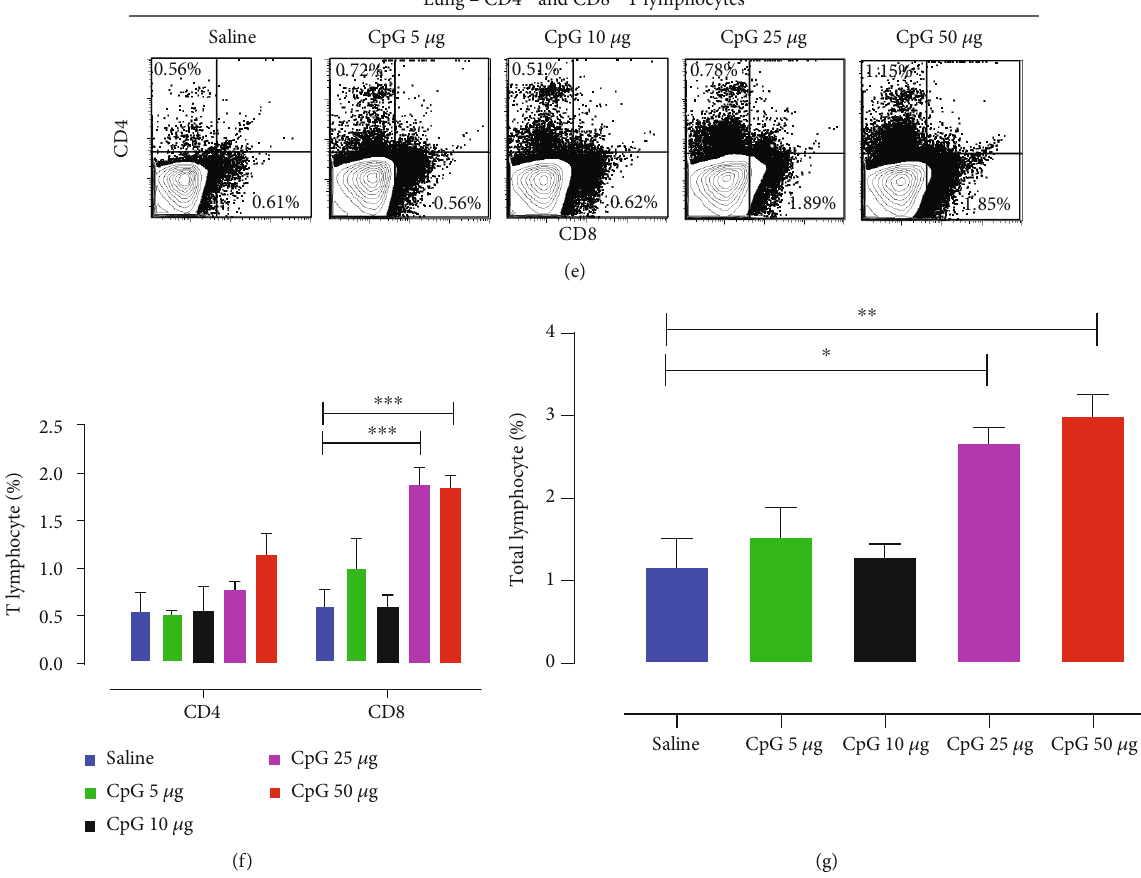
Figure 1: CpG-ODN-induced a dose-dependent enrichment of lung immunological niches. CpG-ODN treatment resulted in an increase in the number of in fi ltrating antigen-presenting cells and T lymphocytes in the lung. Flow cytometric analysis of lung cells at 72 hrs post in ovo injections (day 21 embryo) ( n = 3 ‐ 4/group ). First, cells were plotted based on forward vs. side scatter to gate monocyte/macrophage populations. Then, using PE-labeled mouse anti-chicken monocyte/macrophage (clone: KUL01) and AF488-labeled mouse MHC II monoclonal antibodies, the double-positive population was gated to quantify the number of APCs (dot plot panels, a). Bar diagrams (b) show the means of the total percentage of MHC II + APC in various groups. Histogram panels (c) indicate the level of CD40 expression on MHC II + APCs (the MFI is indicated). Black histogram=isotype control, blue=saline, and red =CpG-ODN treated. Bar diagrams (d) show the means of MFI of CD40 expression on MHC II + APC (vertical line and horizontal bar show the standard error of mean-SEM), n = 3 ‐ 4 . Dunnett ’ s test following ANOVA testing was used to test for signi fi cant di ff erences between CpG-ODN doses and the saline control group. Asterisks indicate groups that were signi fi cantly di ff erent from the control group ( P < 0 : 05 ). (MFI — geometric mean fl uorescence intensity). (e – g) Flow cytometric analysis of lung T-cell populations in each group ( n = 3 ‐ 4 ) at 72hr post in ovo injections (day 1 hatch). CD4 + and CD8 + T-cells in the lung (dot plot panels, e) were quanti fi ed using PE-labeled mouse anti-chicken CD4 and FITC-labeled mouse anti-chicken CD8 monoclonal antibodies. Bar diagrams show CD4 + and CD8 + T-cell number in the lungs (f), and the total number of CD4 + T-cells and CD8 + T-cells combined (g) in various groups. Two-way ANOVA following the Bonferroni posttest was done when CD4 + and CD8 + cells were compared between CpG-ODN received groups and saline control. Dunnett ’ s test following ANOVA testing was used to test for signi fi cant di ff erences in total T-cells between di ff erent CpG-ODN doses and the saline control group. Vertical line and horizontal bar show the standard error of mean-SEM. Asterisks indicate groups that were signi fi cantly di ff erent from the control group, ∗ P < 0 : 05 , ∗∗ P < 0 : 01 , and ∗∗∗ P < 0 : 001